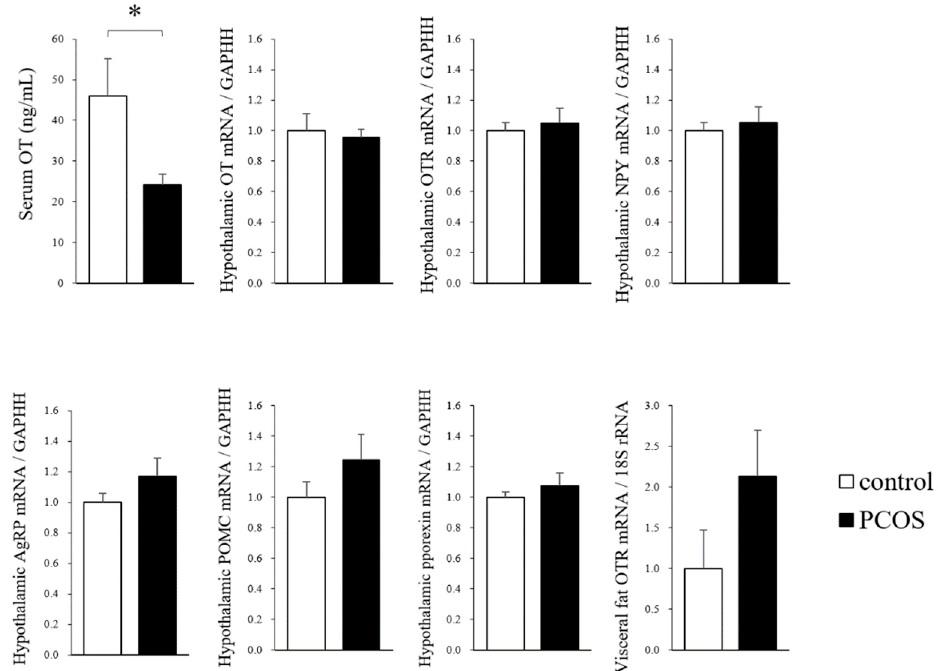
Figure 3. The serum oxytocin (OT) levels, the hypothalamic mRNA expression levels of OT, oxytocin receptor (OTR), neuropeptide Y (NPY), agouti-related protein (AgRP), pro-opiomelanocortin (POMC) and prepro-orexin (pporexin), and the visceral mRNA levels of OTR in the PCOS and Control groups. Data are expressed as the means ± SEM. * p < 0.05.